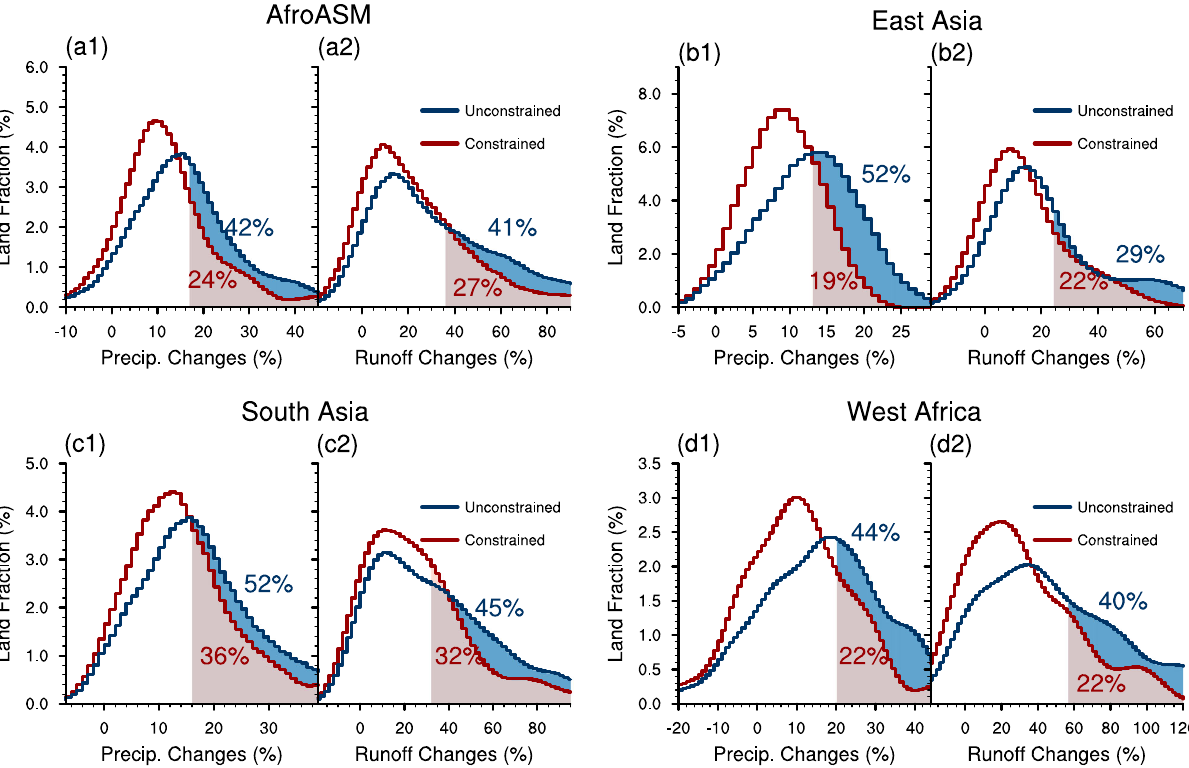
Fig. 6 Spatial distribution of unconstrained and constrained changes in precipitation and runoff. The probability distribution functions (PDFs) are aggregated by the land area fraction that experienced a certain change of precipitation ( a1 – d1 ) and runoff ( a2 – d2 ). The shadings and percentages in the subplots are the land area fraction which will experience a signi fi cant increase in the unconstrained (blue) and constrained (red) projections. The signi fi cant increase is de fi ned as the increase exceeds the range of inter-model standard deviation (see Methods). The constrained projection of runoff is based on the relationship between runoff changes and precipitation changes (see